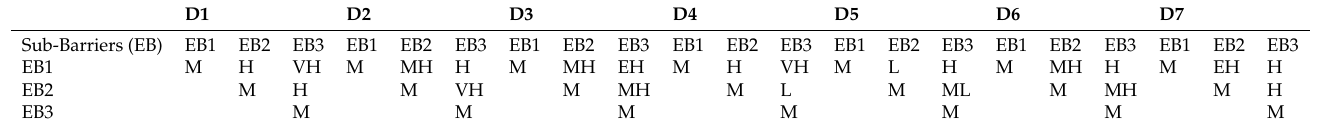
Table A1. The DMs judgments for the environmental sub-barriers using linguistic variables.